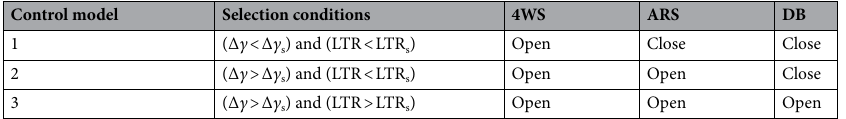
Table 1. collision avoidance strategy of the up-level decision-making layer. 4WS Four-wheel steering, ARS Active rear steering, DB Differential braking.